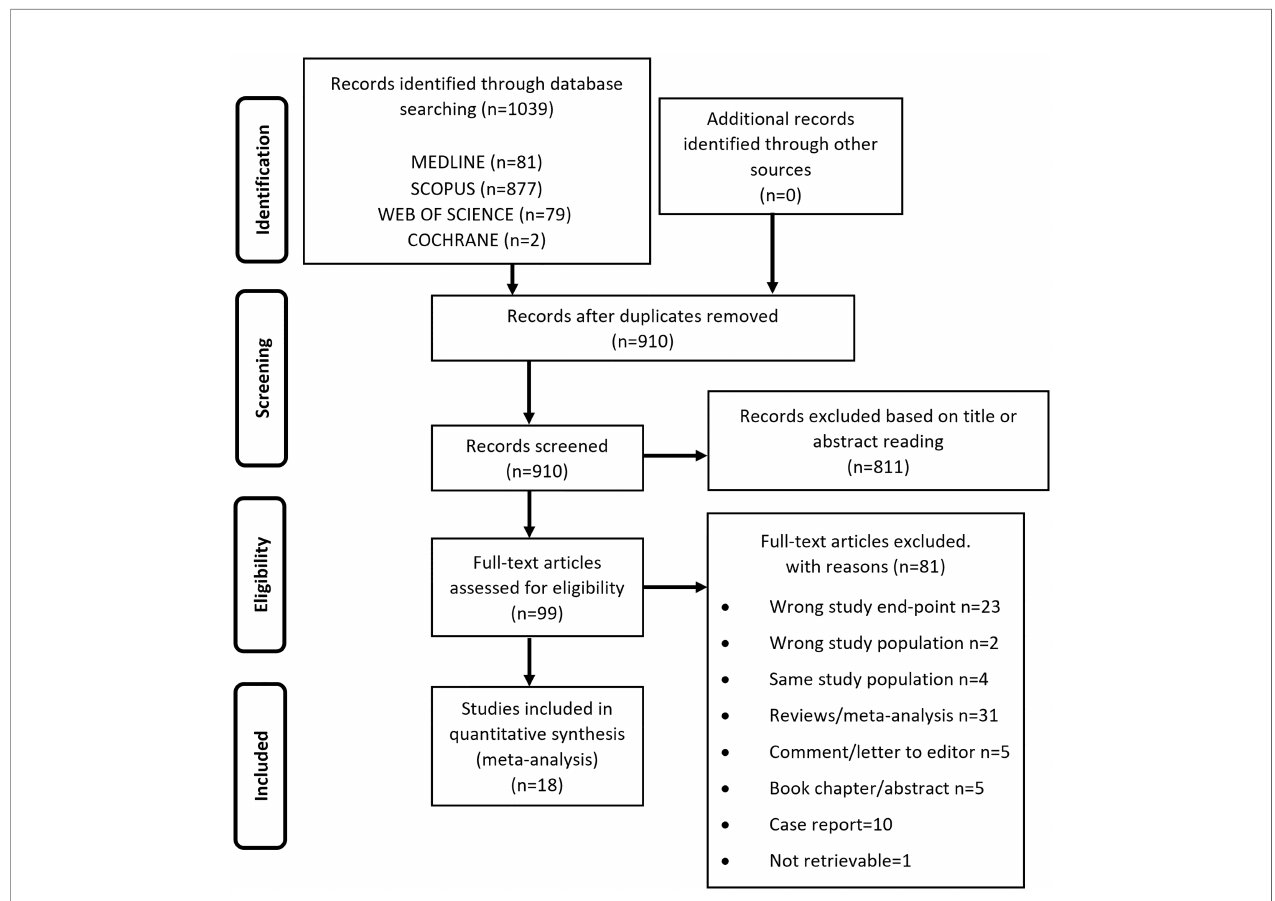
FIGURE 1 | Flow diagram showing an overview of the study selection